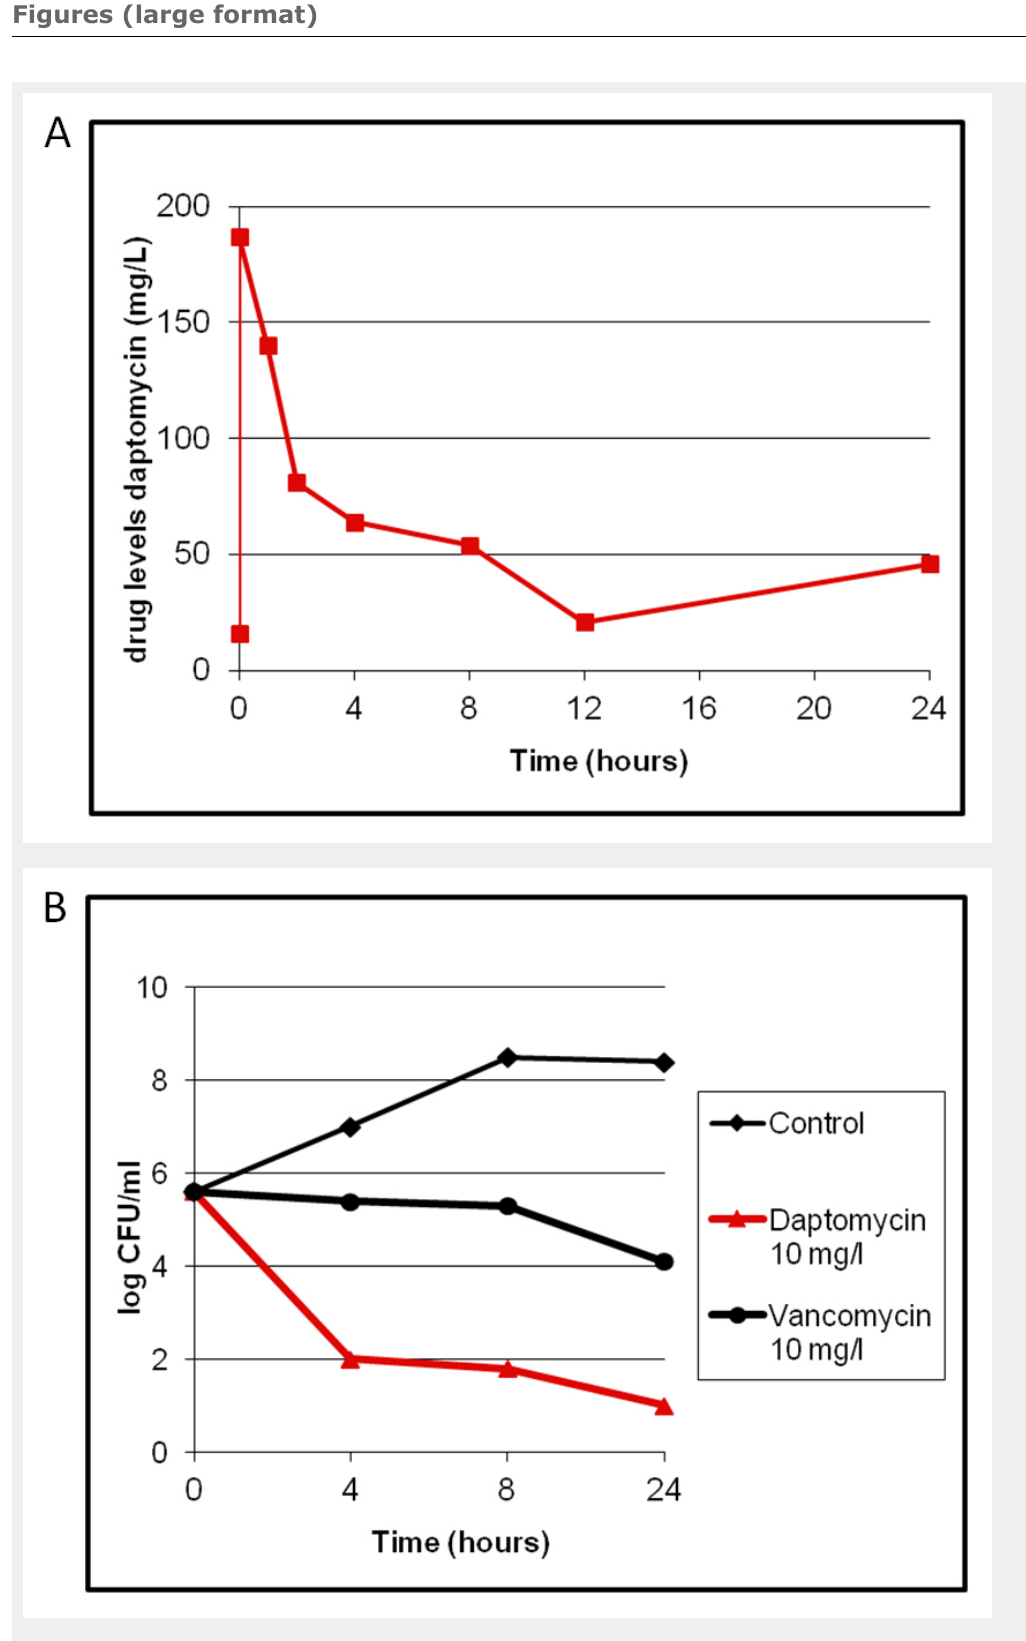
Figure 1 Therapeutic monitoring in one patient with high-dose daptomycin of 10 mg/kg/24 h (A) and in vitro killing curves showing a bactericidal effect of daptomycin at 10 mg/l in contrast to 10 mg/l vancomycin